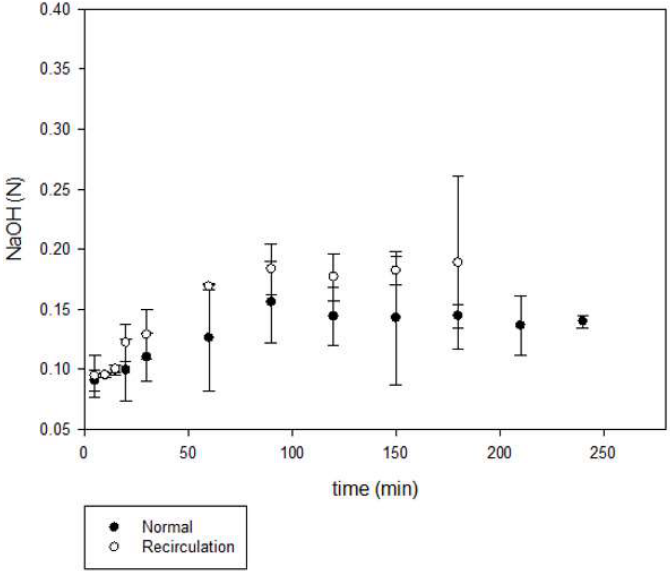
Figure 8. Hydroxide production in normal and recirculation configuration.